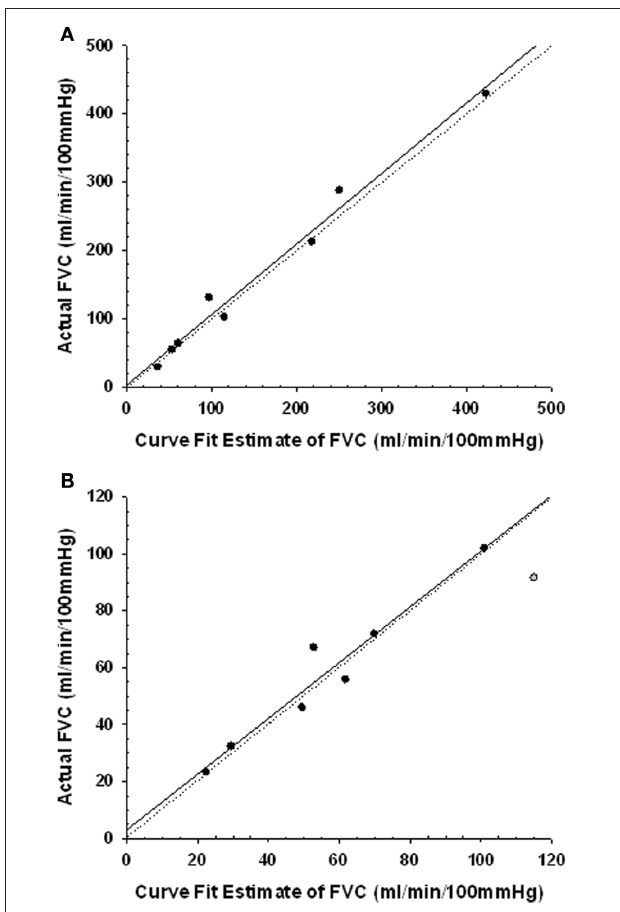
FIGURE 3 | Regression plots of the curve fit estimated forearm vascular conductance (FVC) and the actual FVC during the last 30s of the 2min period in the control post-exercise condition coincident with the timing of the CPT. Line of identity represented by dotted line. Regression represented by solid line. Panel (A) regression for the PE early CPT timing. Panel (B) regression for the PE late CPT timing. One subject data point (gray symbol) was excluded from the regression as it had a Cook’s d -value of 1.6, indicating it had disproportionate impact on the regression